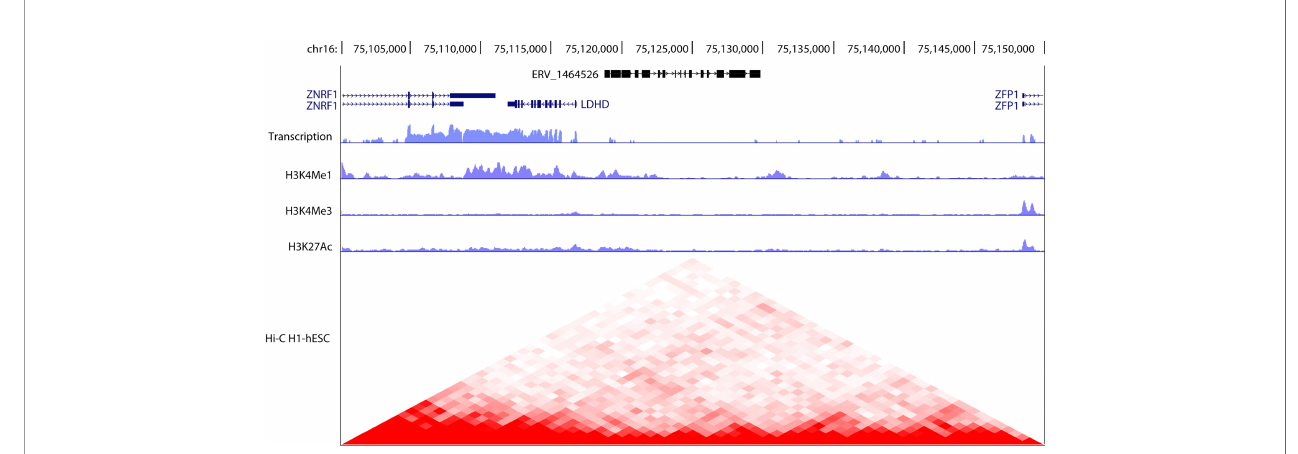
FIGURE 2 | Genomic organization of hERV 1464526 in chromosome 16. Typically, as in this case, ERV elements are discontinuous and interspersed with other genomic elements. hERV_1464526 is interposed between three coding genes (ZNRF1, LDHD, ZFP1). The transcript levels as well as H3K4me1, H3K4me3, H3K27ac and Hi-C data were obtained from UCSC genome browser (https://genome.ucsc.edu/) and refer to human embryonic stem cells (hESC). A drop in the transcriptional activity is observed in correspondence to hERV_1464526 locus, in respect to neighbor coding genes. However, the heterochromatinization of ERV locus is not complete, as observed by H3K4me1 levels. Hi-C data evidence the involvement of ERV locus in chromatin looping dynamics and